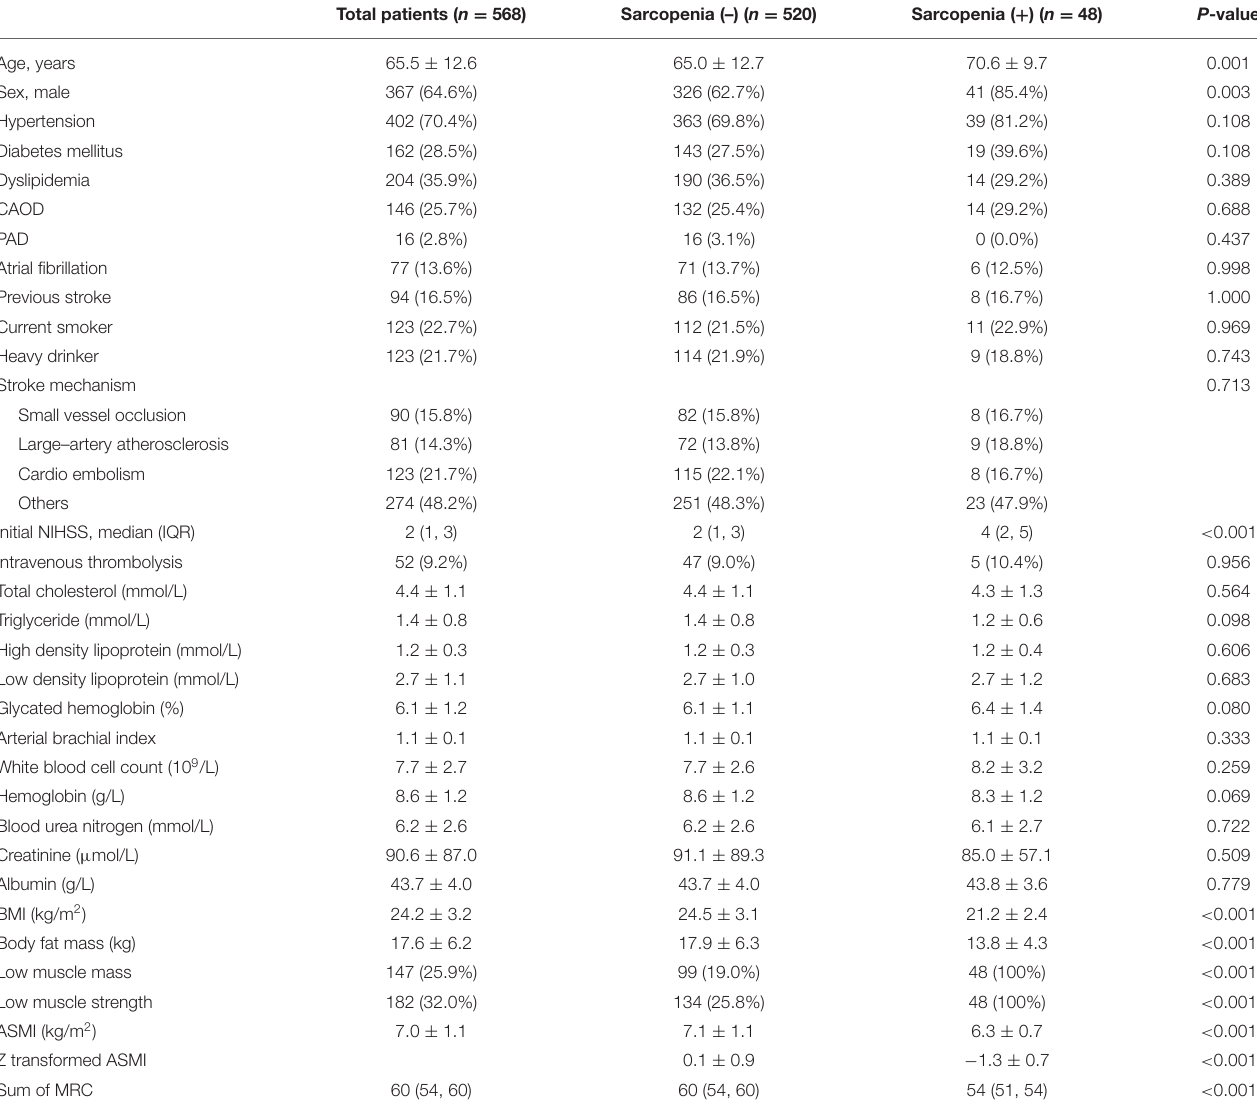
TABLE 1 | Comparison of baseline characteristics by the presence of sarcopenia. Total patients ( n =